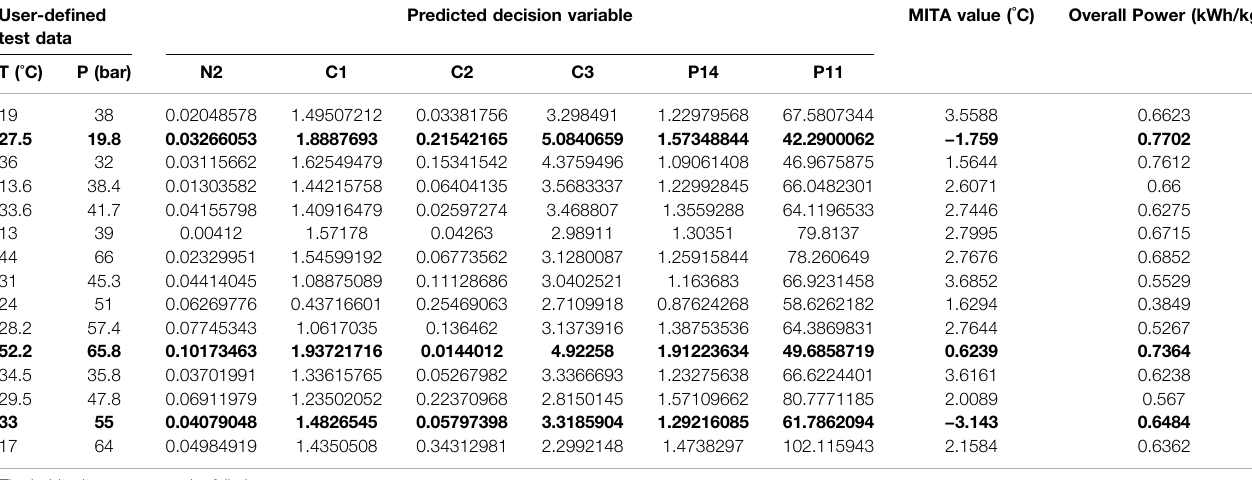
TABLE 12 | PSO-ANN performance: estimated decision variables and their corresponding MITA and overall power values against user-de fi ned test data. User-de fi ned test data